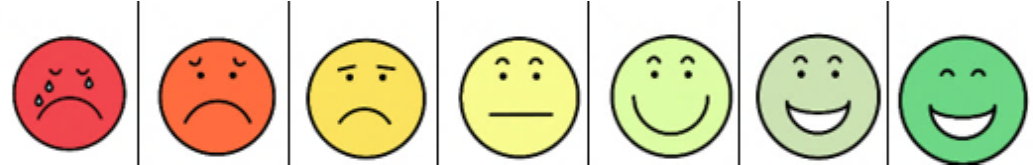
Figure 1. Pictorial representation scale, based on a 7-point Likert scale, for response selection modified for people with